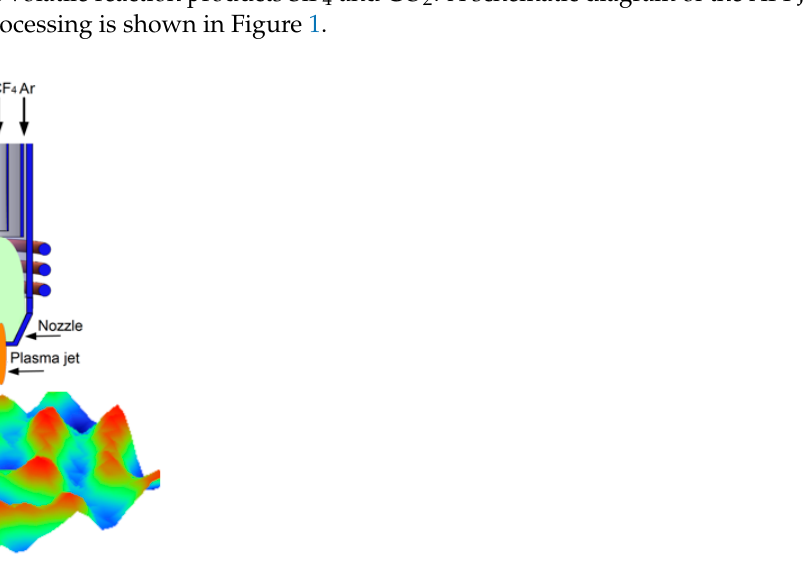
Figure 1. Schematic diagram of the APPJ used for CPP processing.